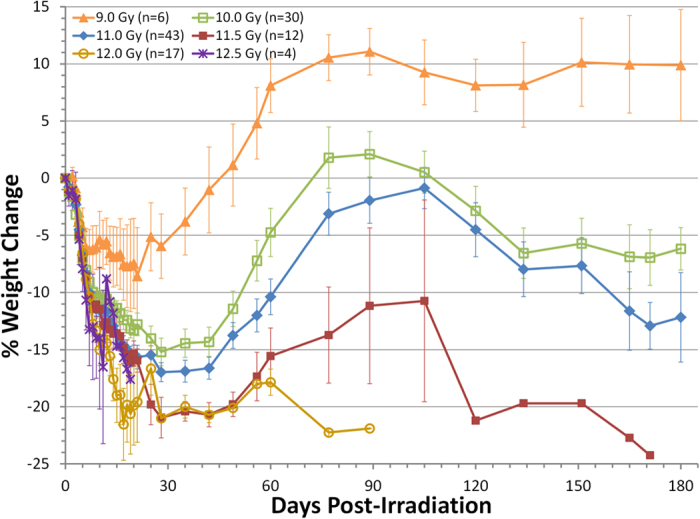
Time course of body weight change of the NHP exposed to 9.0–12.5 Gy PBI/BM5.The % BW change relative to pre-radiation BW is plotted versus days post-irradiation. NHP are grouped according to radiation doses. Mean values (±s.e.m) are displayed for each dose cohort at each time point.